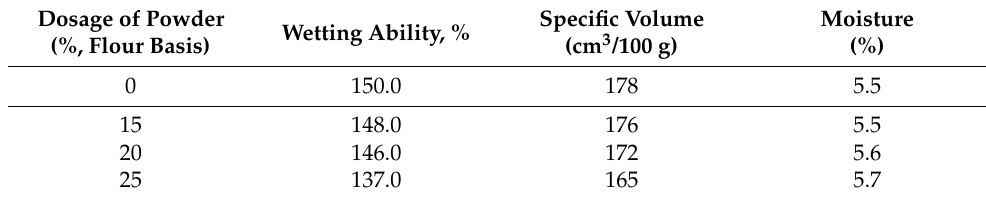
Table 3. The effect of grape seed powder on the quality of butter